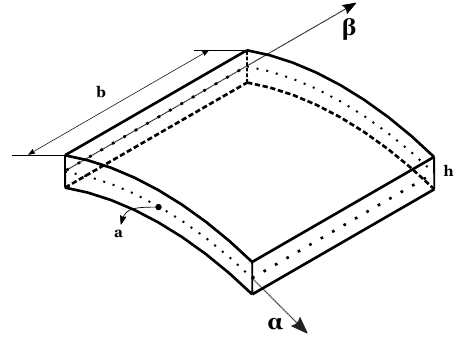
Figure 6. The cylindrical shell geometry for Case 3.